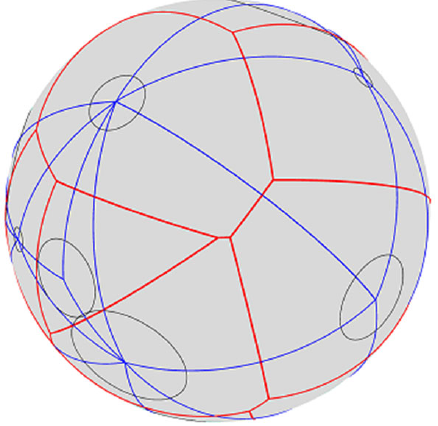
Figure 3. Spherical power diagram. Where the green circle is spherical circle of each point with center v i and radius r i , the red spherical polygon is spherical power cell of each point, and the blue spherical triangle is cell’s dual triangle.